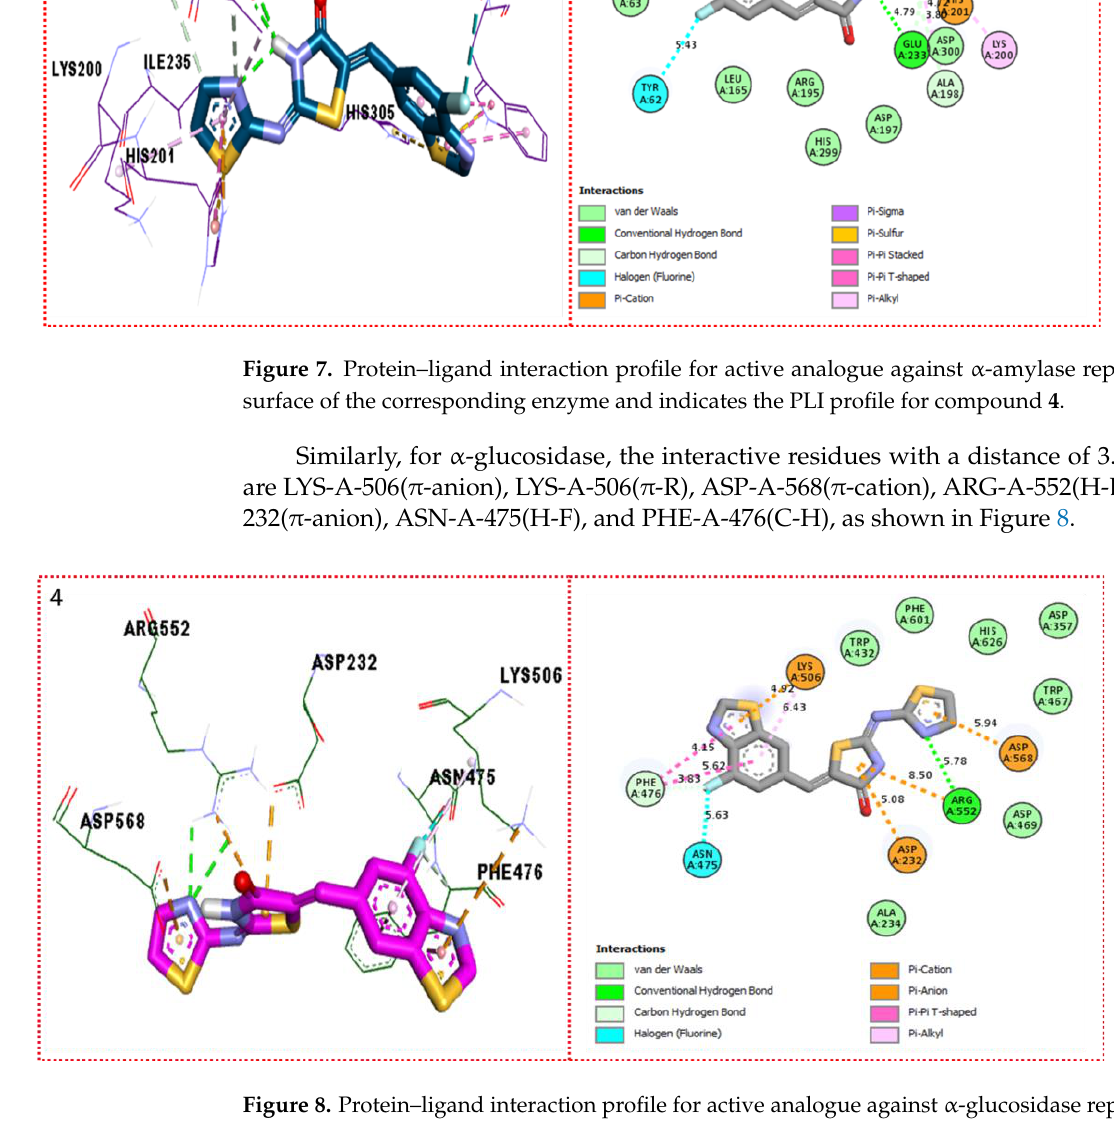
Figure 9. Protein – ligand interaction profile for active analogue against α‐ amylase represents the surface of the corresponding enzyme and indicates the PLI profile for compound 5 . Similarly, for α‐ glucosidase, the interactive residues with a distance of 4.04 – 7.52 A are ARG-A-552(H-B), PHE-A- 476(π -S), PHE-A- 476(π - π -stacked), ASP-A- 232(π -anion), MET-A- 470 (π -S), TRP-A- 432(π - π -T-shaped), ASP-A-568(H-B), and ASP-A- 469(π -anion), as shown in Figure 10.